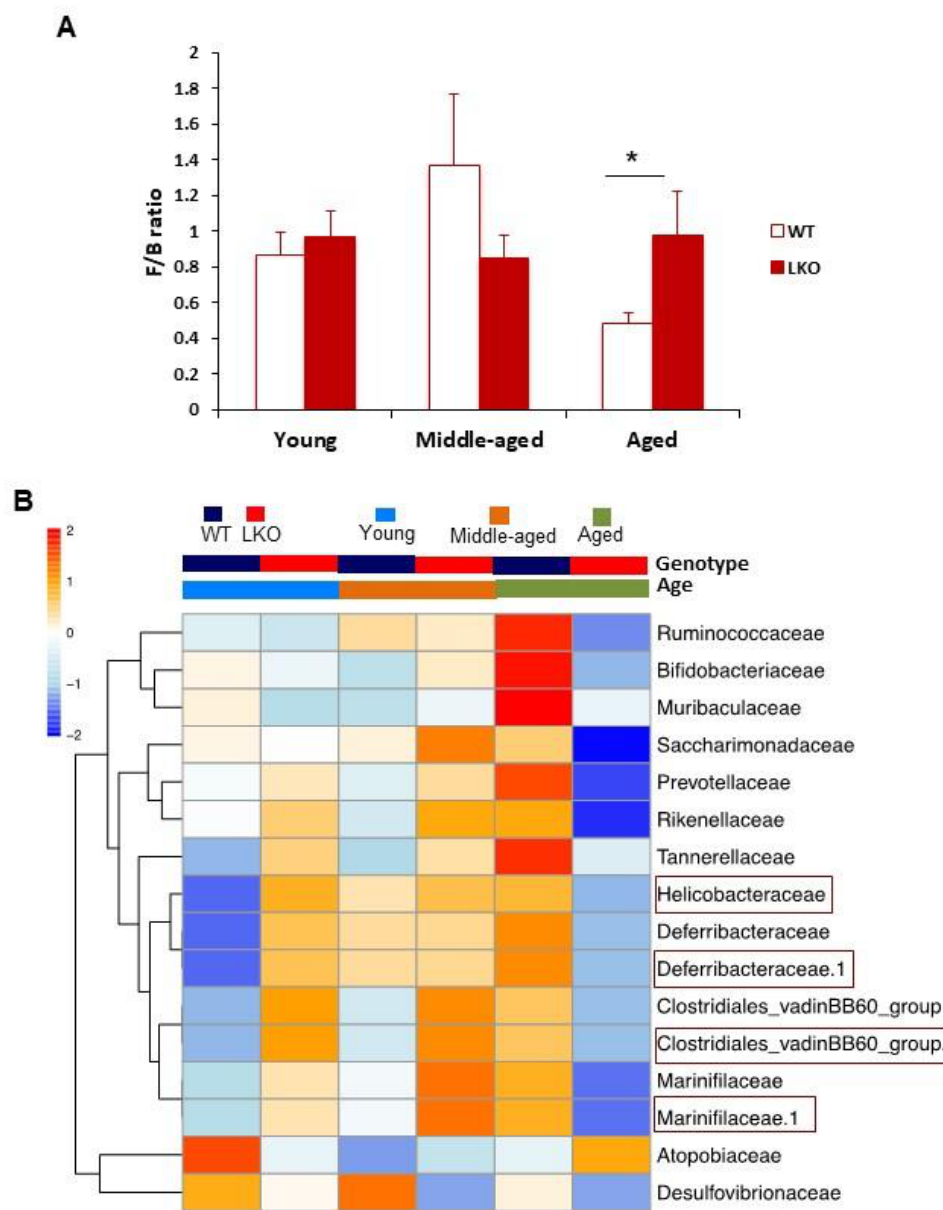
Figure 3. Identification of differentially abundant bacteria between WT and LKO mice during aging. ( A ) The ratio of Firmicutes to Bacteroidetes (F/B) in WT and LKO mice at all three stages of age. Data are presented as mean ± SEM (n = 6–9). * p < 0.05 versus old WT mice. * p < 0.01 versus young WT mice ( B ) Hierarchal clustering analysis (HCA)-based heatmaps on differentially abundant, including both increased and decreased, microbes at the family level between WT (n = 9, 4 cages) and LKO (n = 6, 4 cages) mice based on a negative binomial generalized linear model in the R environment. Highlighted bacteria were significantly more prevalent in LKO mice. q value ≤ 0.05 and log2 scale fold change ≥ 2 were the criteria to determine